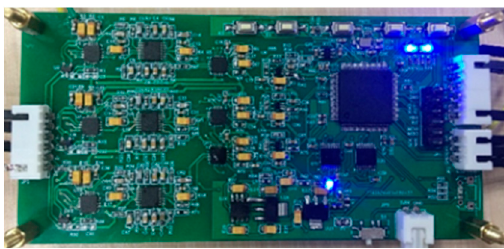
Figure 10. Circuit board of the signal conditioning and processing subsystem.